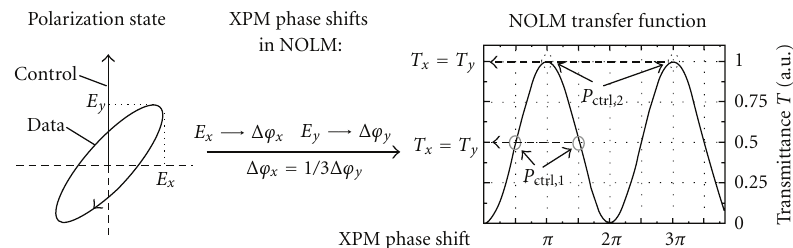
Figure 17: Principle behind polarization-independent operation of a standard NOLM.